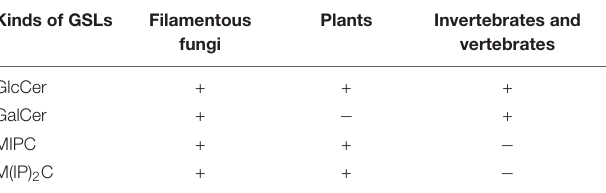
TABLE 2 | Relative presence of glycosphingolipids (GSLs) in filamentous fungi, plants, invertebrates, and vertebrates. Kinds of